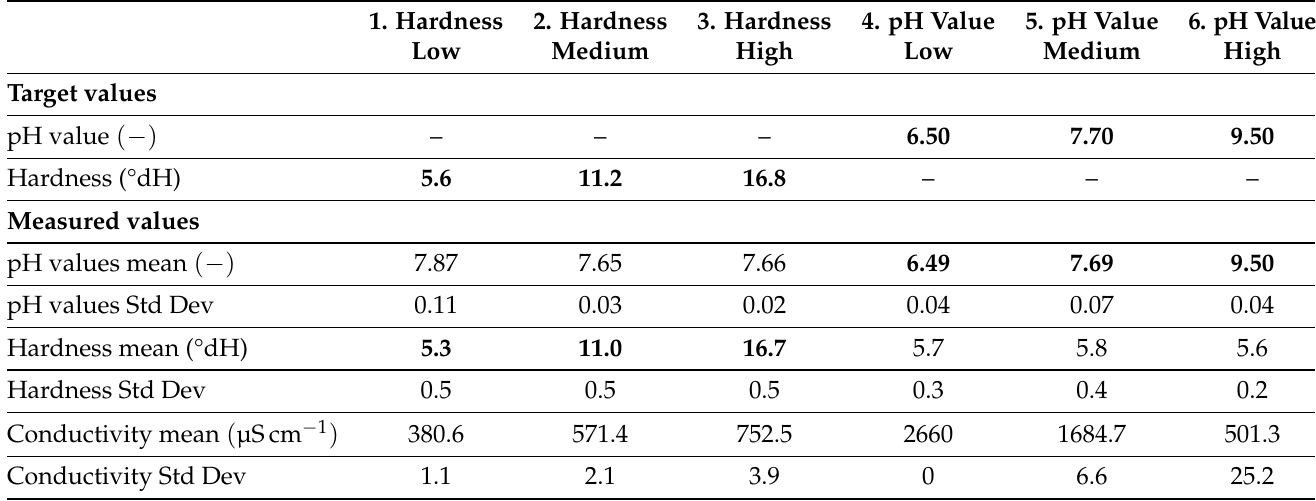
Table 11. Overview of the target values and measured values during the accelerated wear